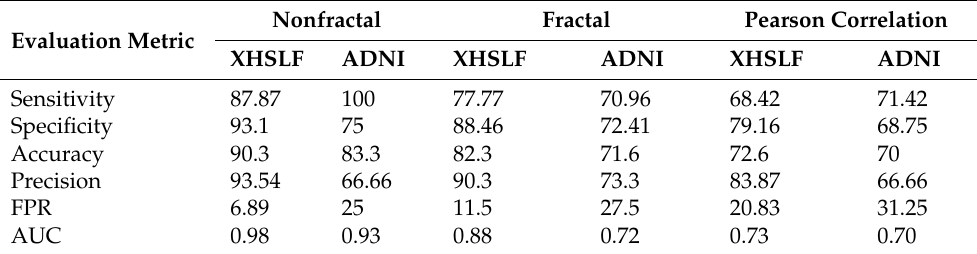
Table 5. Sensitivity, specificity, accuracy, precision, FPR (in %) and AUC of classification of AD vs. NC based on functional connectivity of rs-fMRI and support vector machine for dataset XHSLF and ADNI.